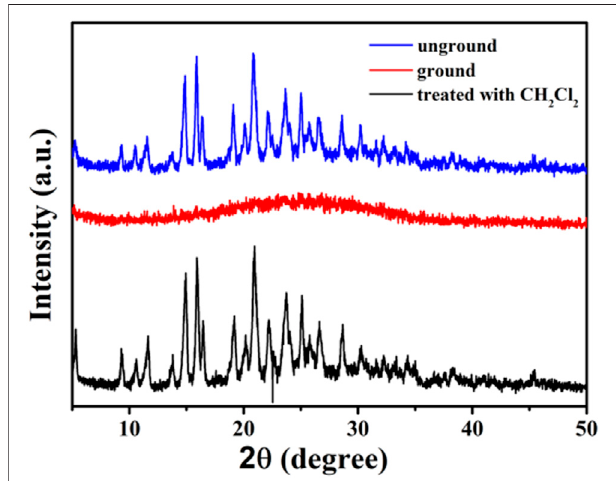
FIGURE 7 | XRD patterns of compound 1 in different solid states: unground, ground, and after treatment with dichloromethane solvent